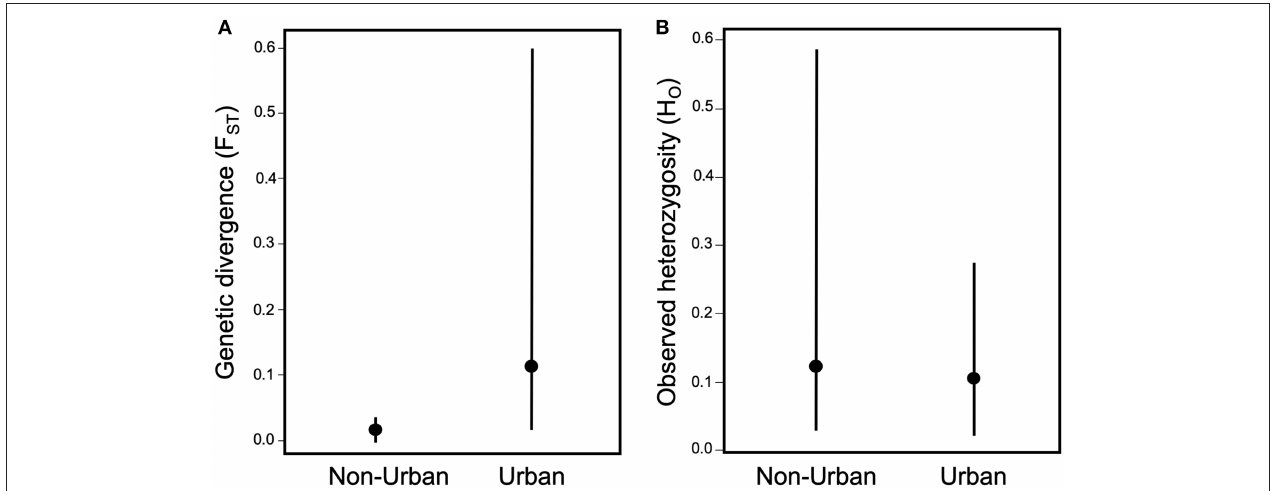
FIGURE 4 | Effect of urbanization on (A) genetic differentiation between populations measured as F ST , and (B) genetic diversity within populations measured as observed heterozygosity (H O ). Measures of F ST are the mean of pairwise values between urban populations and the mean of pairwise values between non-urban populations, extracted from the studies ( Supplemental Table 1 ) of non-adaptive evolution in herbivorous arthropods. Measures of H O are the mean values of urban populations and the mean values of non-urban populations extracted from the studies of non-adaptive evolution ( Supplemental Table 1